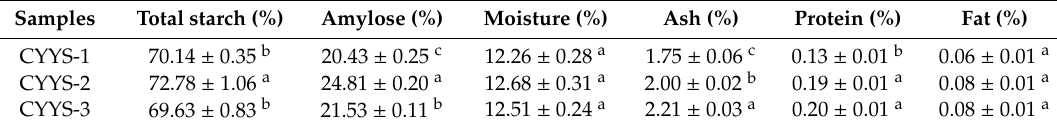
Table 1. The composition of CYYS-1, CYYS-2, and CYYS-3 A